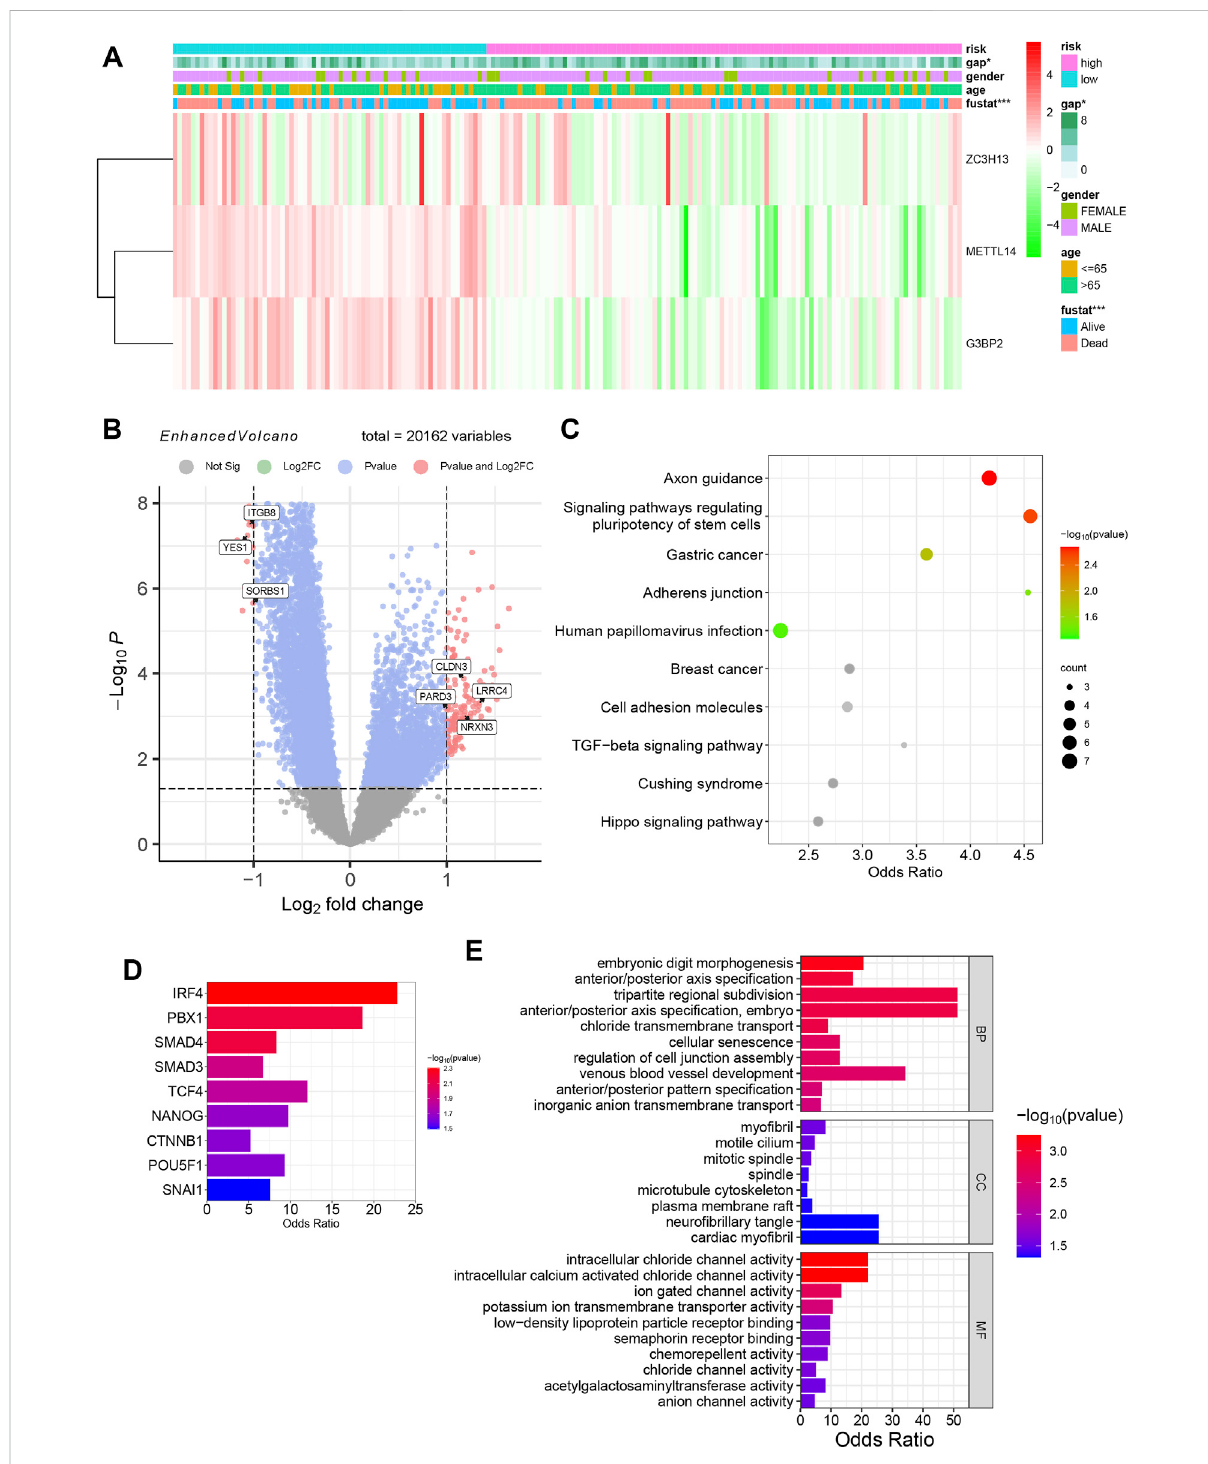
FIGURE 5 Biological characteristics of different m6A risk groups. (A) Heatmap of m6A risk groups with clinical information. (* p < 0.05; *** p < 0.001). (B) The enhanced volcano plot of DEGs between different m6A clusters. (C) KEGG pathway analysis of different m6A clusters. (D) Bar graph of transcription factor prediction using TRRUST. (E) GO annotation enrichment, including BP, CC, and MF analysis of various m6A